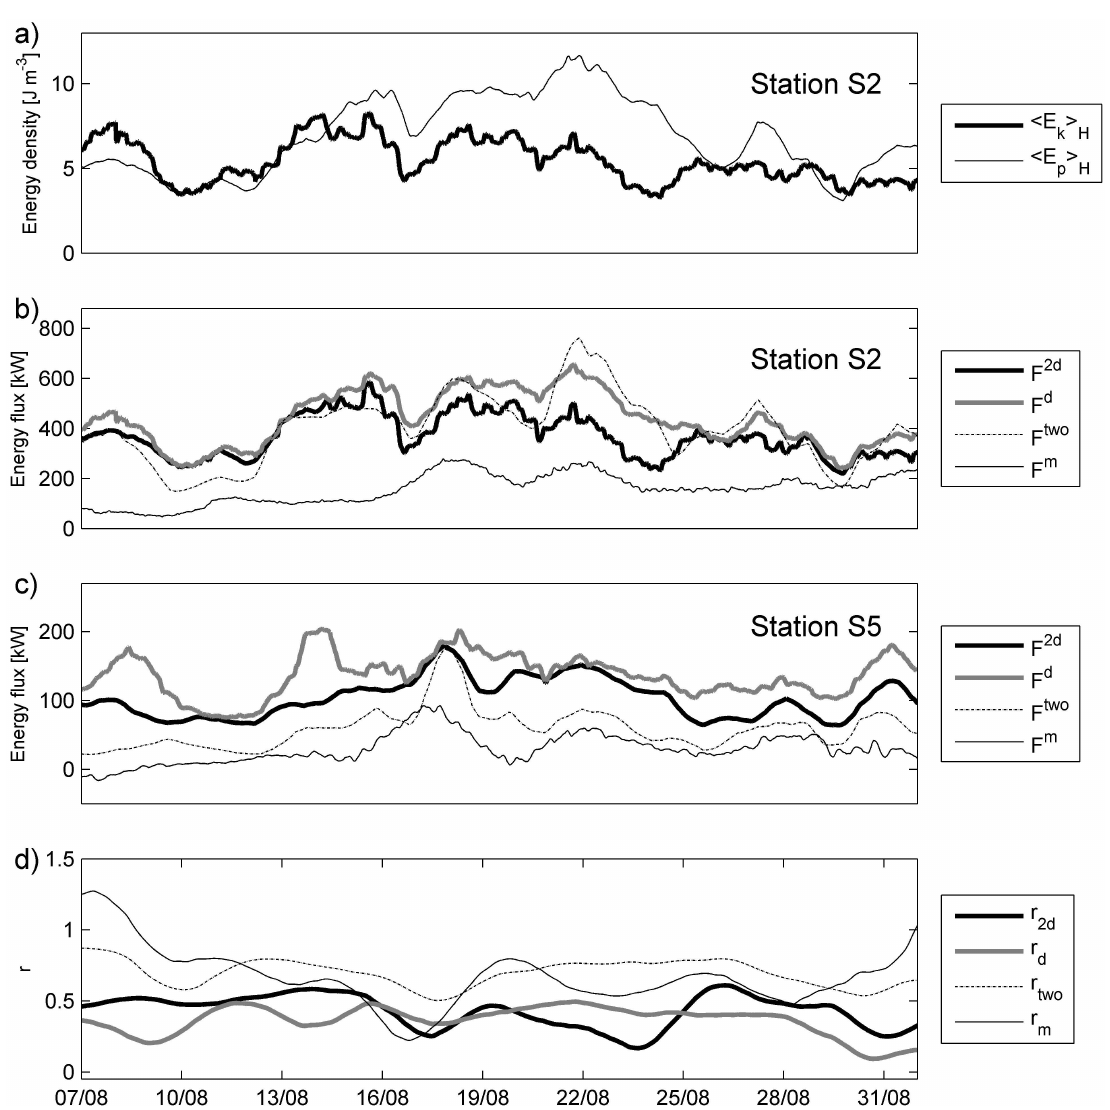
Fig. 12. (a) The depth-averaged perturbation energy densities (cid:10) E p (cid:11) and h E k i at station S2. (b) – (c) The energy flux F calculated with different methods at stations S2 and S5. (d) The relative loss r of baroclinic energy flux in the area between stations S2 and S5 calculated from Eqs. (21) and (22) with f = 1. At the start of the period, there is a negative energy flux at station S5 calculated with the normal mode method, resulting in a value of r > 1. Table 4. Mean energy fluxes and mixing efficiency during the measurement period. Mixing efficiency in the entire inner Oslofjord is calcu- lated by using values for work against buoyancy (Eq. 23) based on data from 2003 and 2009 where the result varied in the range 20 to 40kW. Estimates of energy loss between station S2 and S5 are based on Eq. (21) with a value of f in the range 0.5 to 1.5. Method Energy flux at Energy density method F d (Eq.